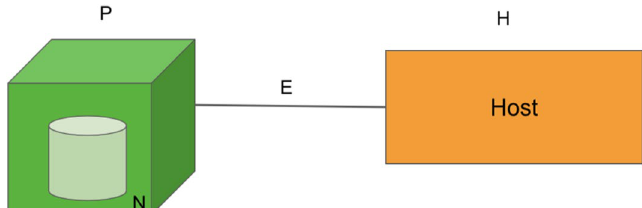
Fig. 5 Basic building block of the bipartite dengue contact